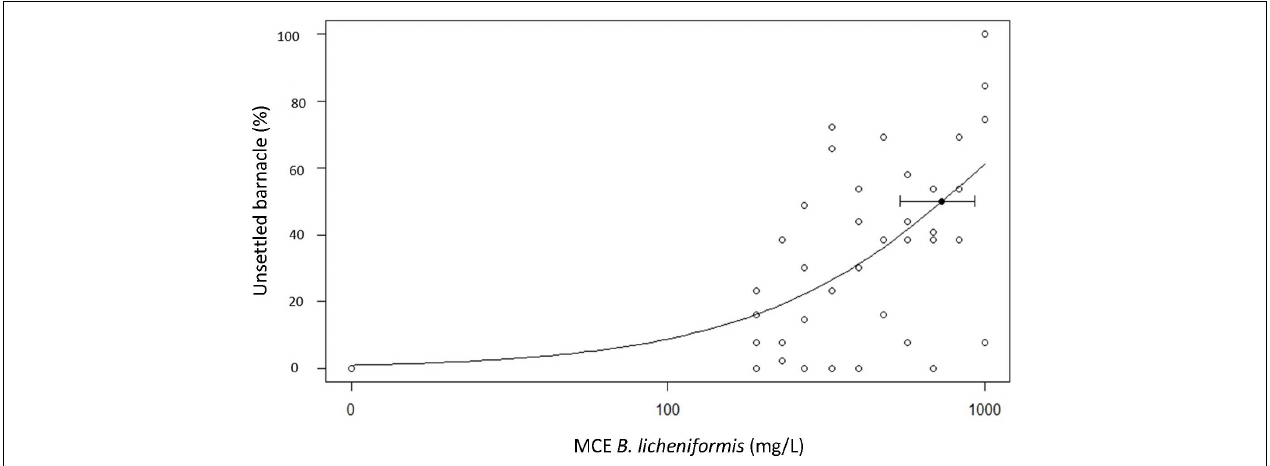
FIGURE 5 | Percentage of cyprid barnacles Amphibalanus amphitrite not settled after exposure to a dilution series of the methanol cell extract (MCE) of Bacillus licheniformis . Median Efficacy Concentration EC50 plotted with 95% Confidence Intervals. EC50 = 733.60 mg/L (95% CI = 539.24–927.96).